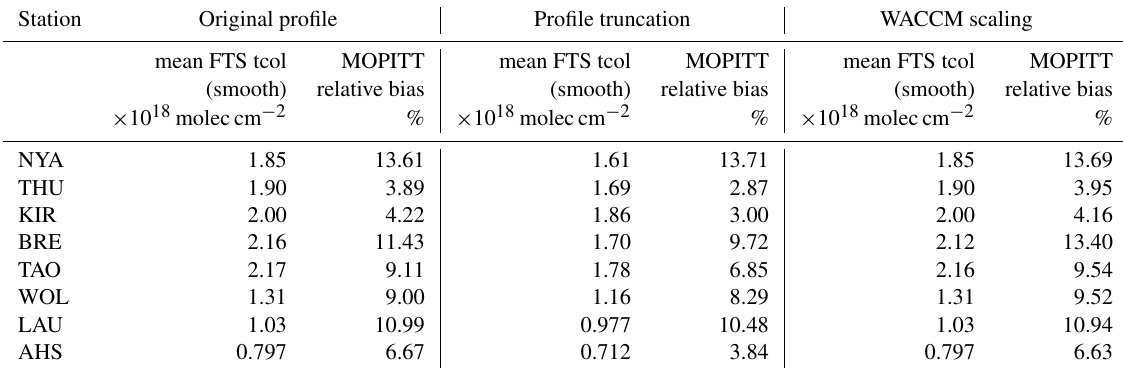
Table C1. Evaluation of replacement or removal of the lowest level (V6 TIR–NIR). MOPITT relative bias is (MOPITT–FTS)/FTS. Station